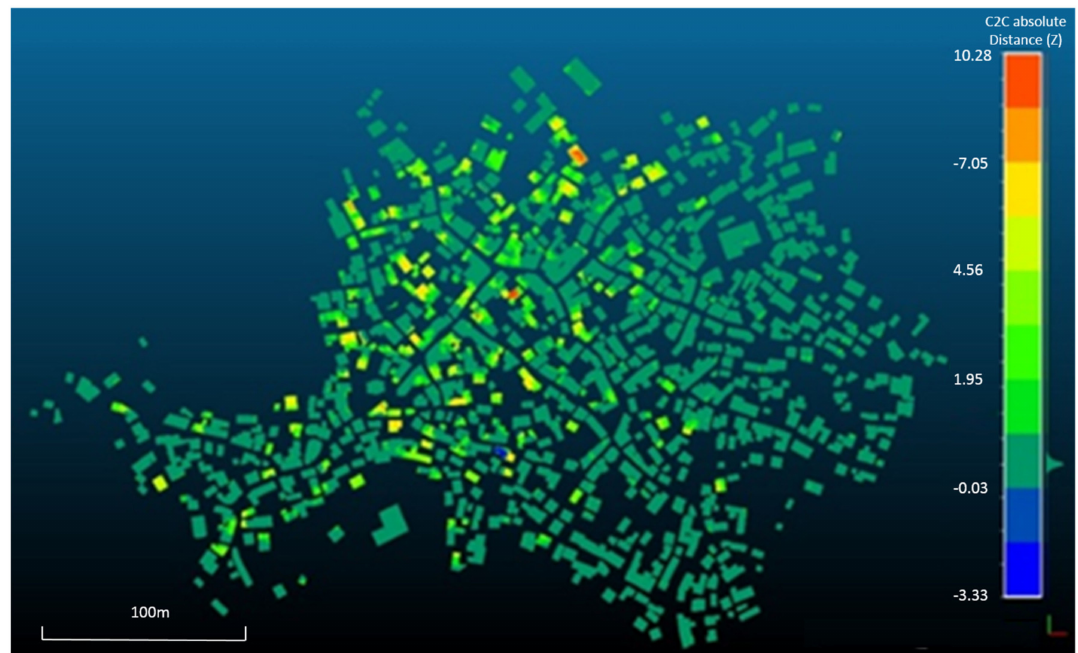
Figure 8. The absolute distances in z axis for the total area of building stock. Warm colors depict the demolished buildings.